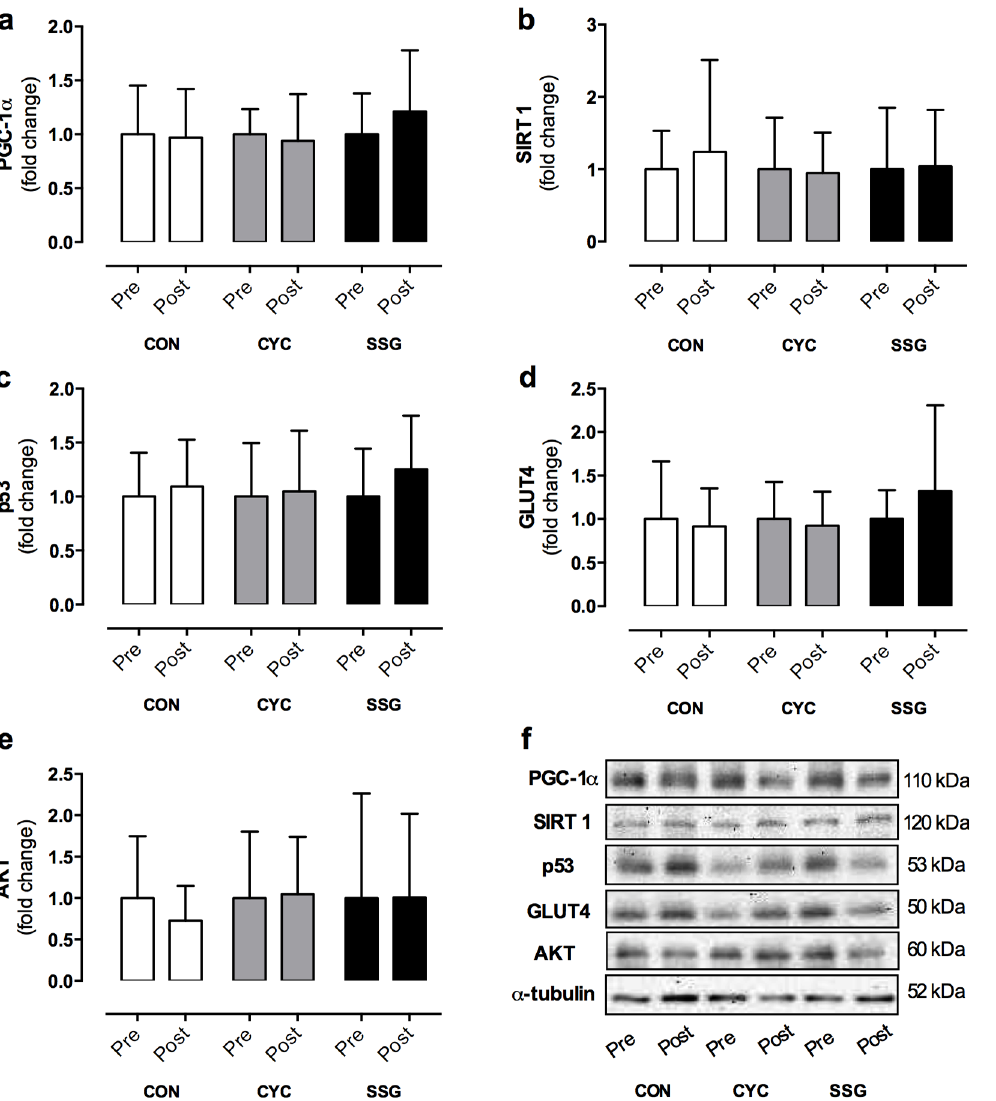
Fig 2. Total protein content of PGC-1 α (a), SIRT-1 (b), P53 (c), GLUT4 (d), AKT (e) and representative blots corrected to α -tubulin (f) before (pre) and after (post) 8-weeks of control (CON; n = 9), continuous cycling (CYC; n = 11) or small-sided games (SSG; n = 10) conditions. Post values are expressed as fold change relative to pre